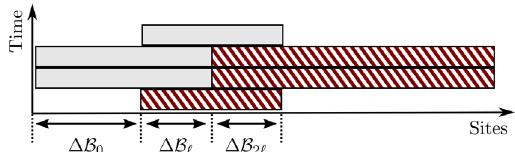
FIG. 1. Demonstration of the second-order product formula for simulating the evolution of an observable B supported on S ð B Þ ¼ Δ B 0 . Each rectangle represents a unitary supported on the sites covered by the width of the rectangle. The evolution unitary e − itH is decomposed using the second-order product formula into ϒ ¼ 2 stages. Each stage is a sequence of Γ ¼ 3 matrix exponentials generated by Hamiltonian terms supported on parts of the system. Some of these unitaries (red shaded rectangles) can subsequently be commuted through B in the t Þ B S t Þ to cancel out with their Hermitian expression S † trunc ð trunc ð conjugate. As a result, the time-evolved version of B can be effectively described by the remaining unitaries (light-gray